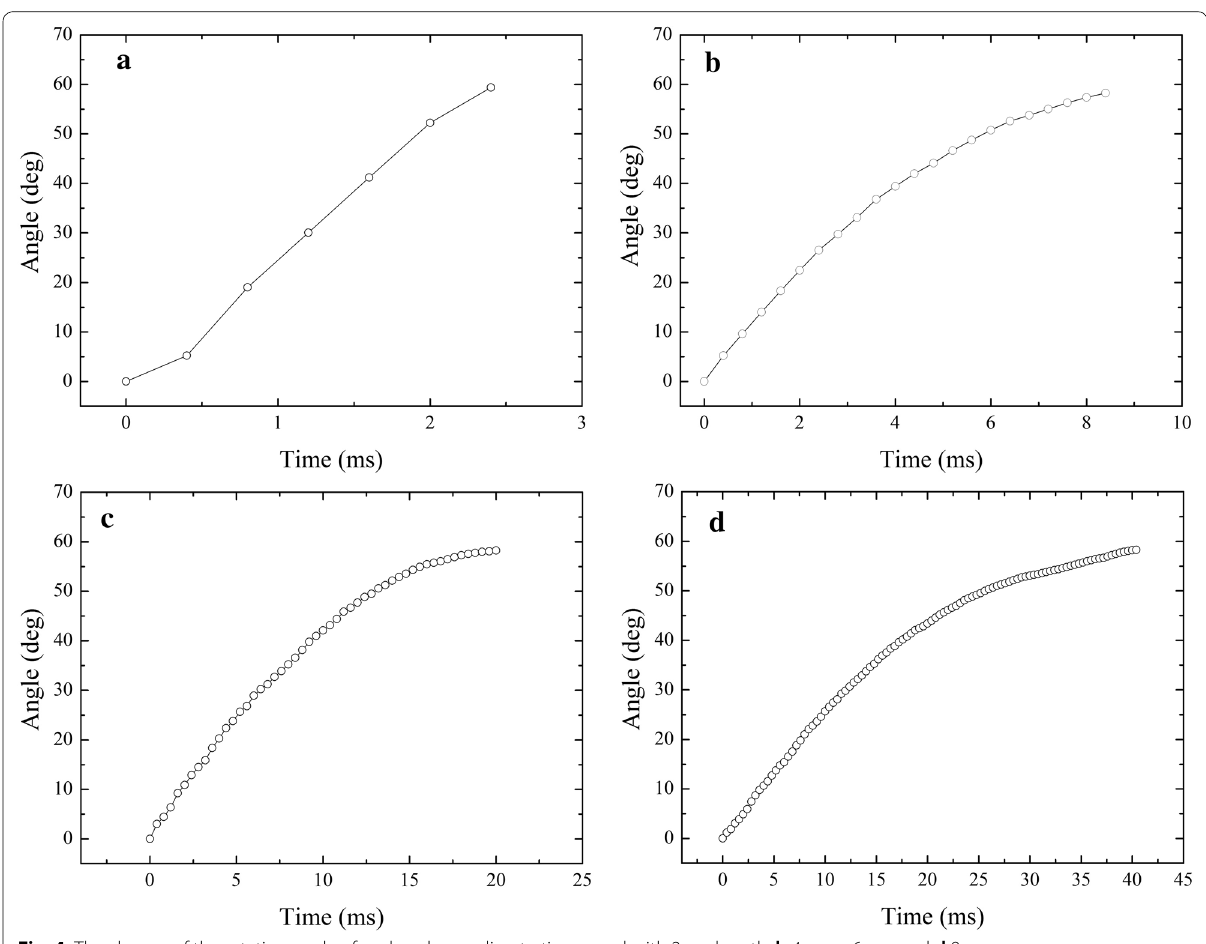
Fig. 4 The change of the rotating angle of each rod according to time: a rod with 2 cm length, b 4 cm, c 6 cm, and d 8